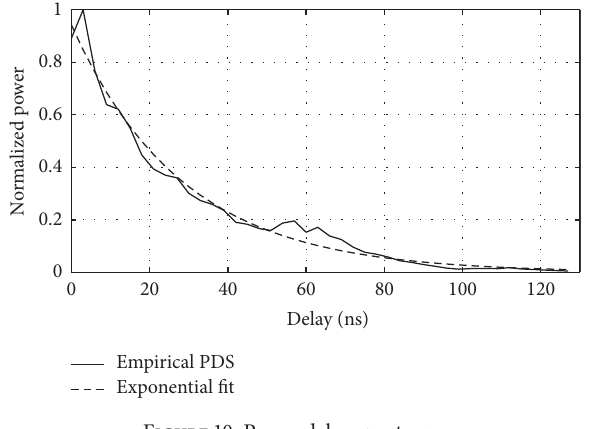
Figure 10: Power delay spectrum.